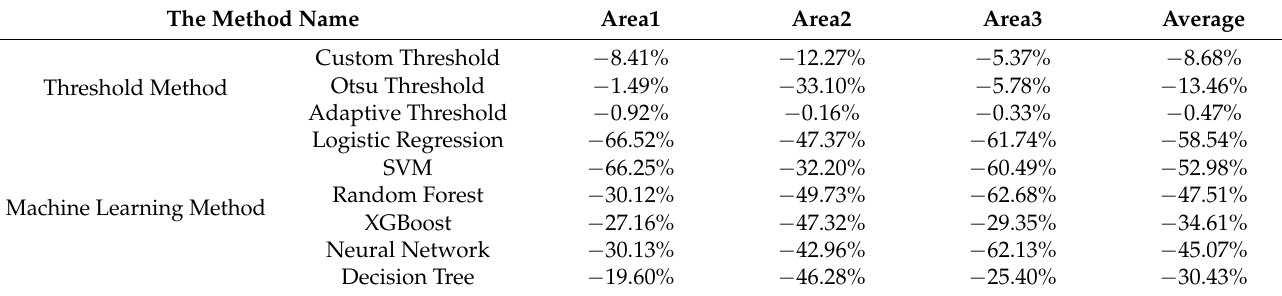
Table 4. AUC index changes statistics of each machine learning